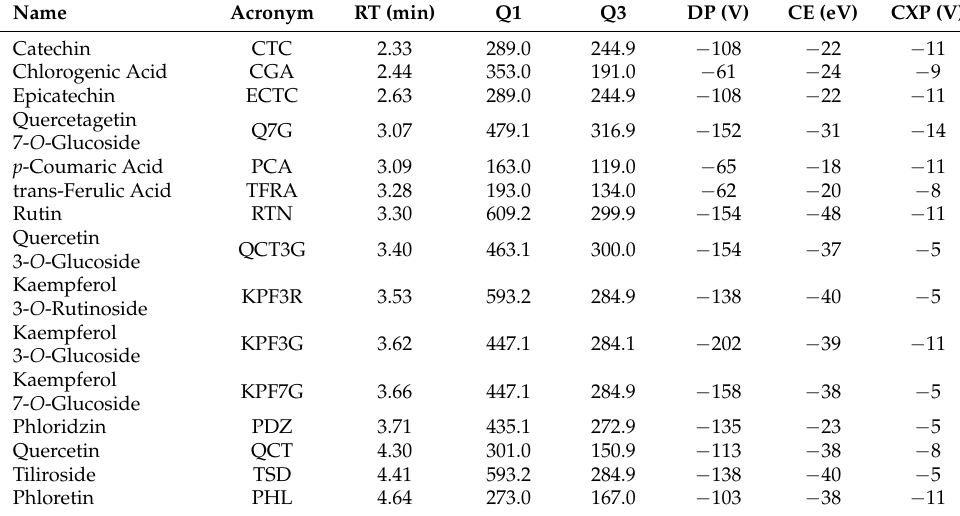
Table 1. Selected reaction monitoring transitions and optimized method and retention times (RT) of selected phenolic